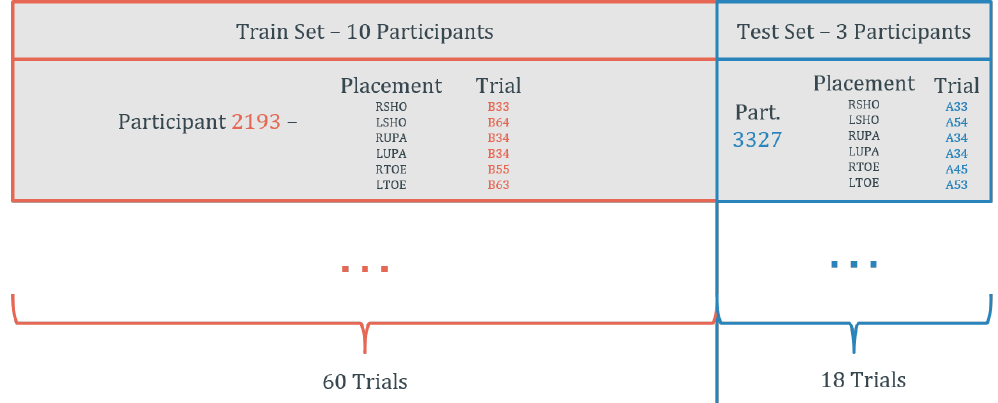
Figure 2. Train and test split (RSHO, Right Shoulder; LSHO, Left Shoulder; RUPA, Right Upper Arm; LUPA, Left Upper Arm; RTOE, Right Toe; LTOE, Left